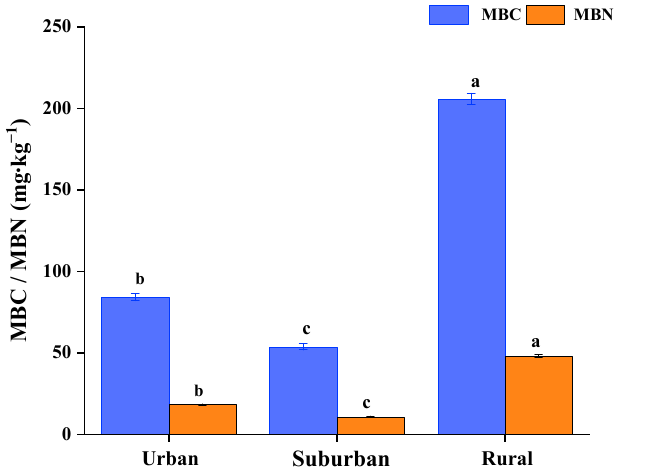
Figure 2. MBC and MBN contents in Quercus acutissima forest soil along the urban–rural gradient. Different letters in each column indicate significant differences in soil samples ( p < 0.05).